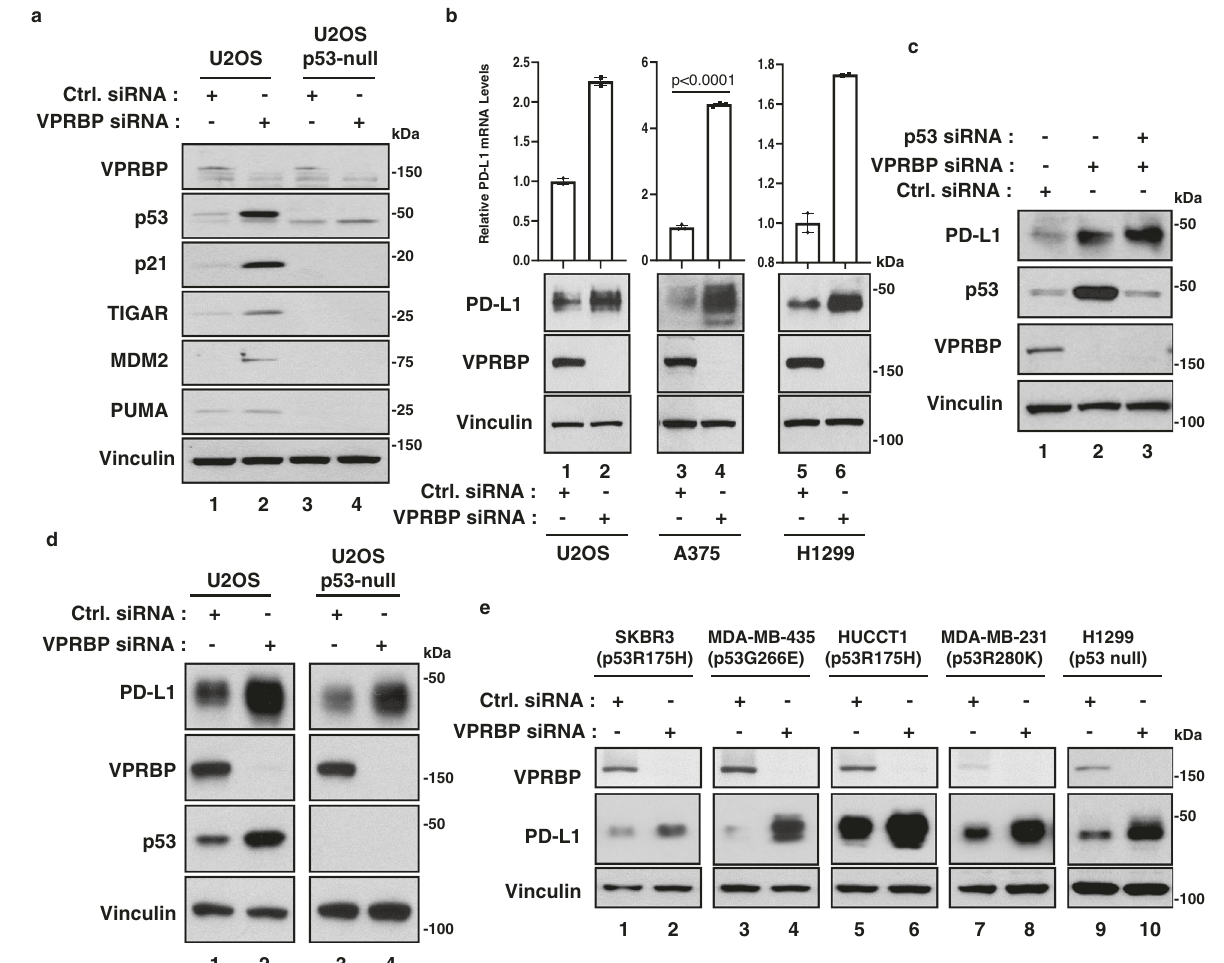
Fig. 1 | Inactivation of VPRBP induces p53-independent upregulation of PD-L1 expression. a , d Western blot analysis of U2OS crispr control or p53 -null cells that were transfected with the control or VPRBP siRNA. b Representative qRT-PCR and western blot analysis of U2OS, A375, and H1299 cells that were transfected with controlorVPRBPsiRNA. n (U2OSandH1299)=2biologicallyindependentsamples, n (A375)=3 biologically independent samples, mean±SD, two-tailed unpaired t -